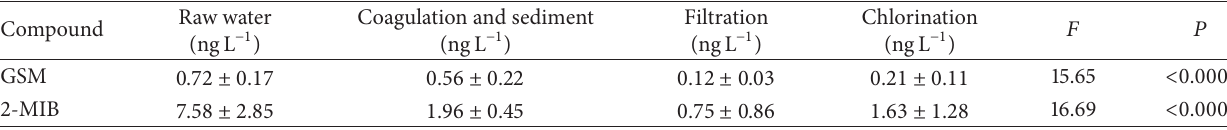
Table 3: Water samples from different processes of tap water treatment ( 𝑛 = 20 ).